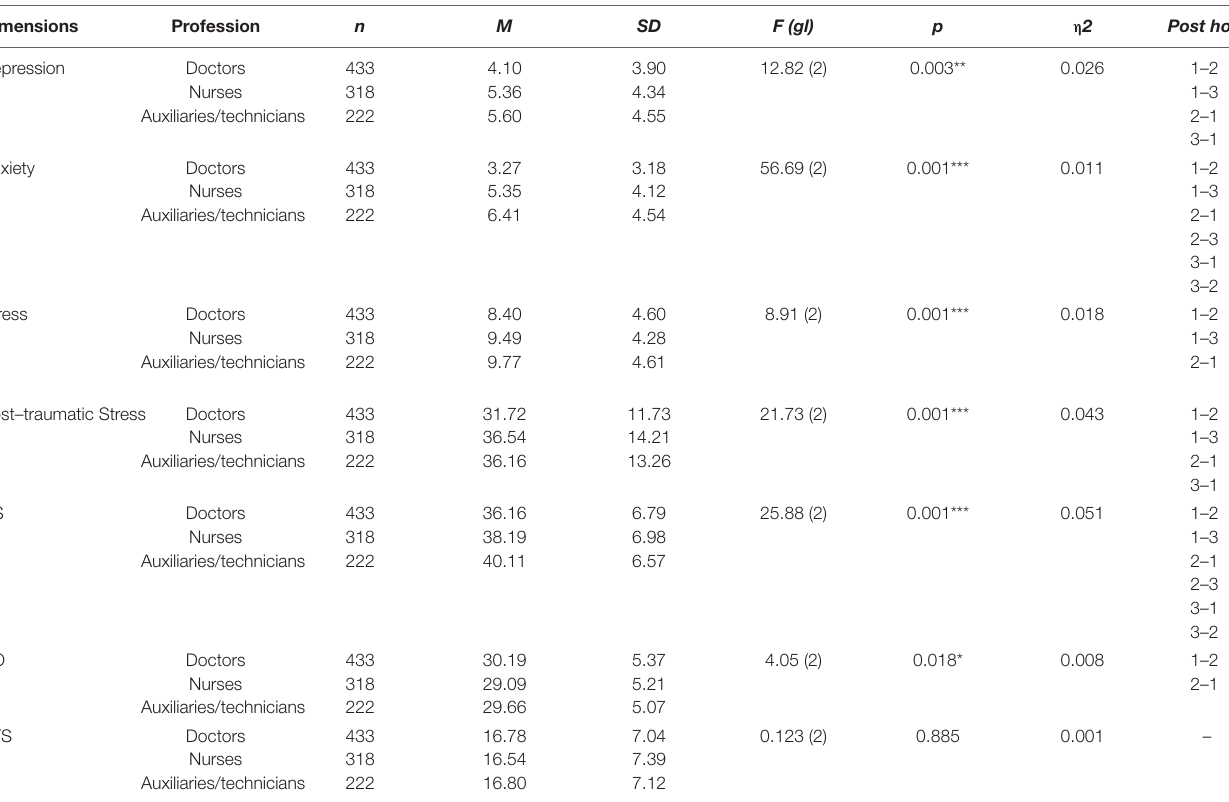
TABLE 5 | Differences in the averages of the variables under study according to professional category. Dimensions